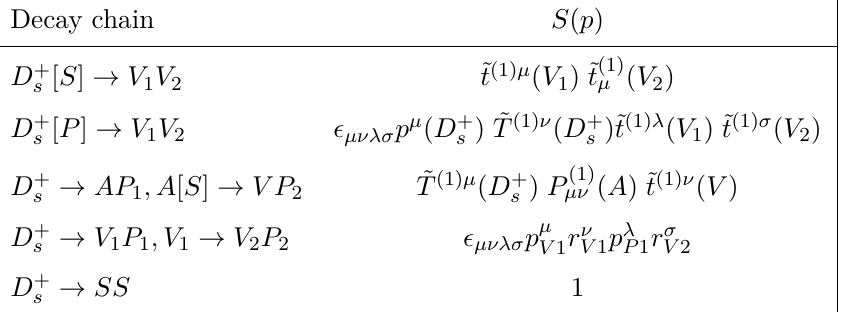
Table 7 . The spin factors S ( p ) for various components. All operators, i.e. ˜ t and definitions as in ref. [35]. Scalar, pseudo-scalar, vector and axial-vector states are denoted by S , P , V and A , respectively. The [ S ] and [ P ] denote the orbital angular-momentum quantum numbers L = 0 and 1,